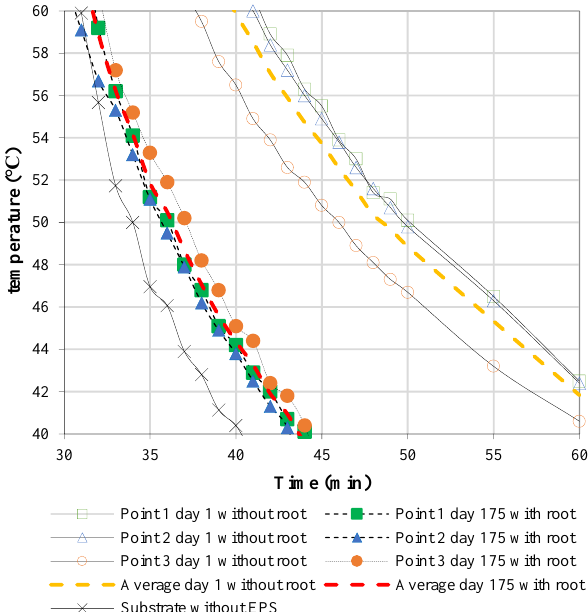
Figure 9. The heat preservation property of substrate with and without plant roots.